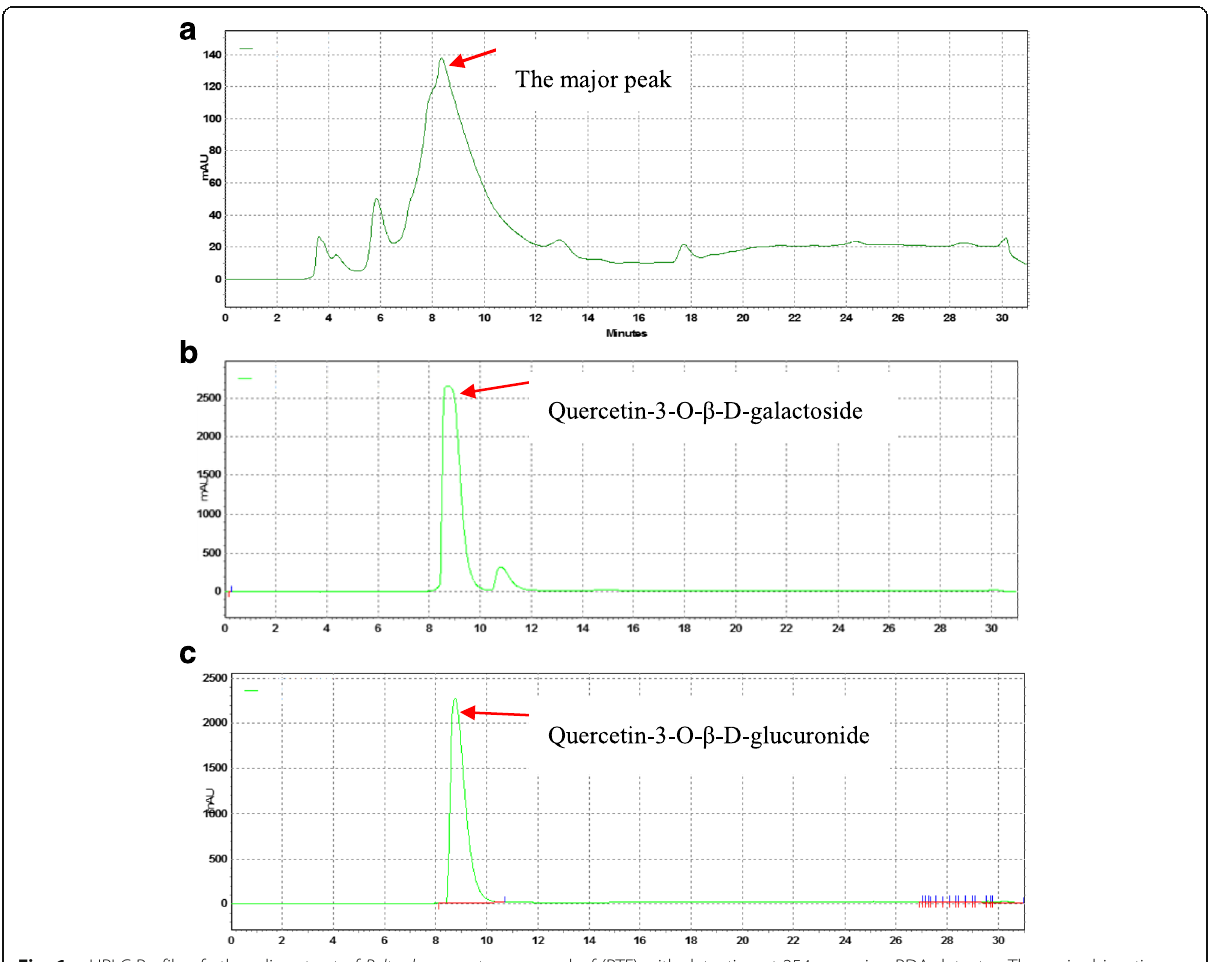
Fig. 1 a HPLC Profile of ethanolic extract of Peltophorum pterocarpum leaf (PTE) with detection at 254 nm using PDA detector. The major bioactive peak at retention time (RT) of 8.514 min that contains mainly quercetin derivatives namely b Quercetin-3-O- β -D-galactoside (hyperoside) and c Quercetin-3-O- β -Dglucuronide